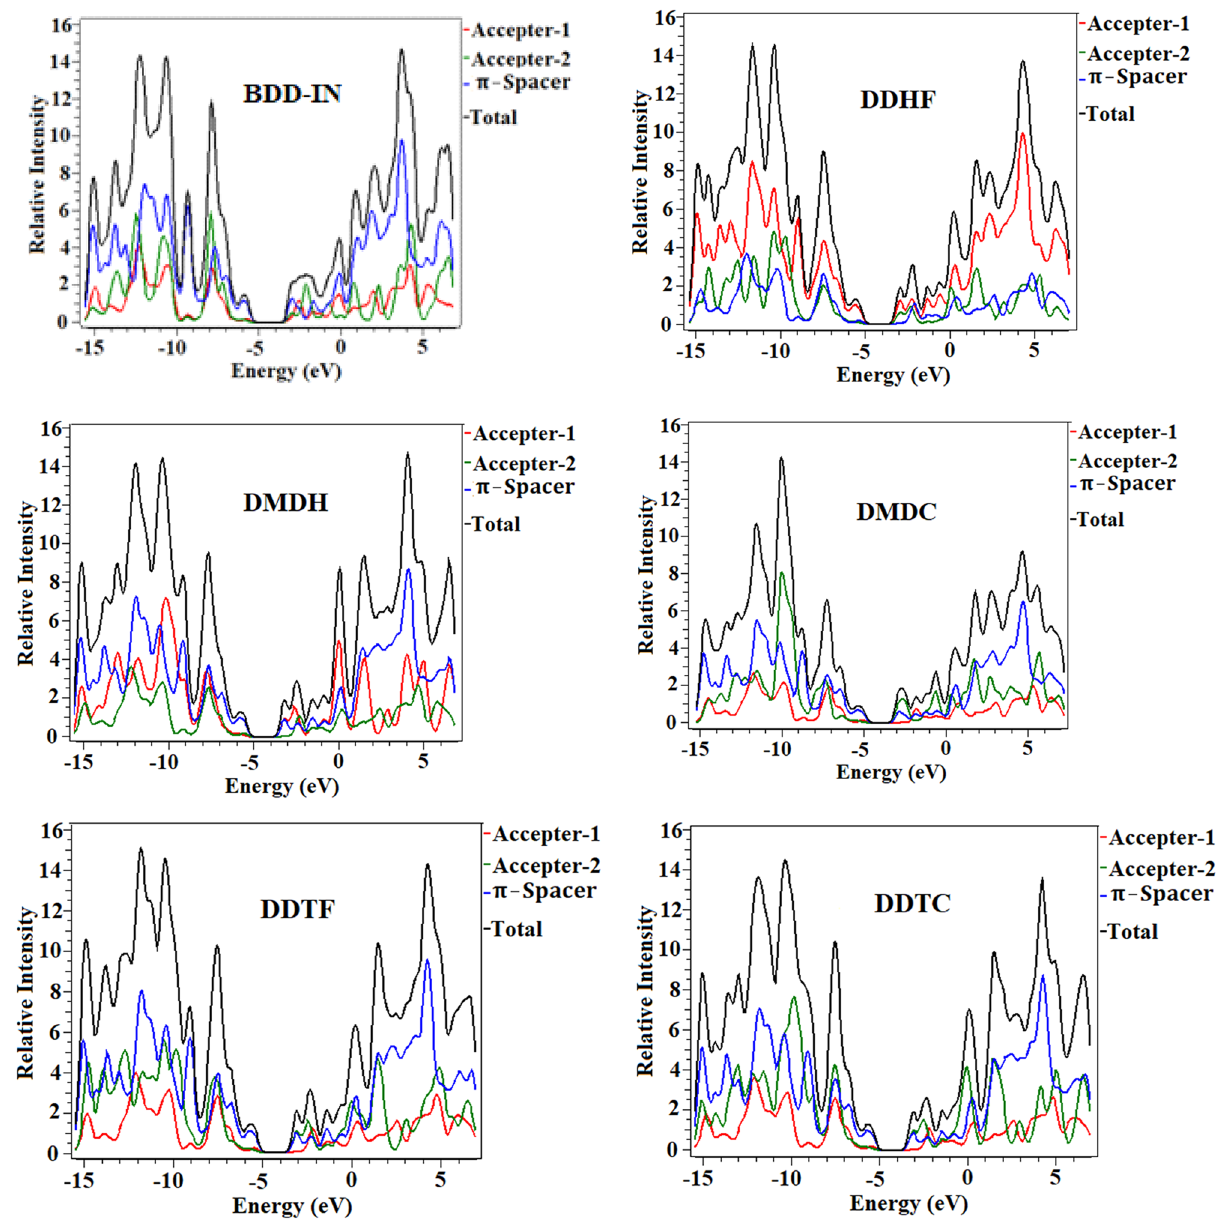
Figure 5. Graphical representation of the density of states (DOS) for BDD-IN, DDHF-DDTC drawn by utilizing PyMOlyze 1.1 version (https:// sourc eforge. net/ proje cts/ pymol yze/). All out put files of entitled compounds were accomplished by Gaussian 09 version D.01 (https:// gauss ian. com/ g09ci tation/).